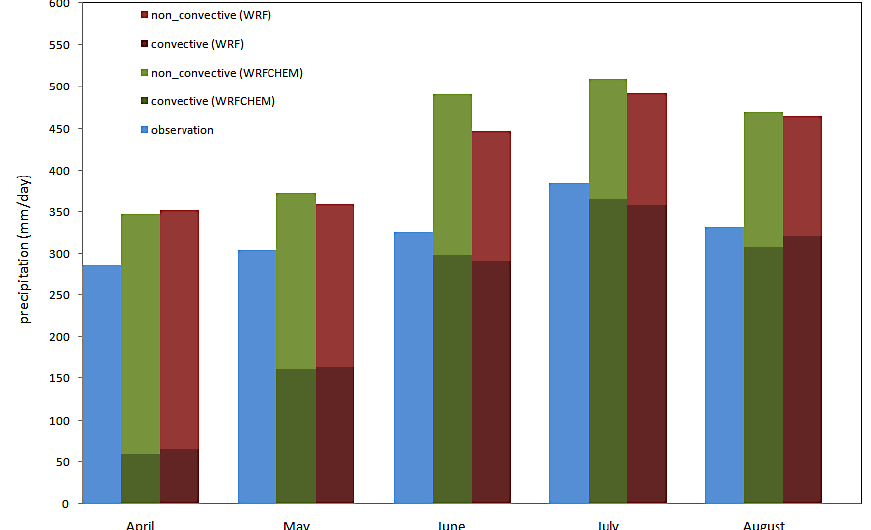
Figure 5. Comparison of observed total daily precipitation integrated over all the monitoring sites shown in Fig. 1 with the convective and non-convective precipitation simulated by WRF and